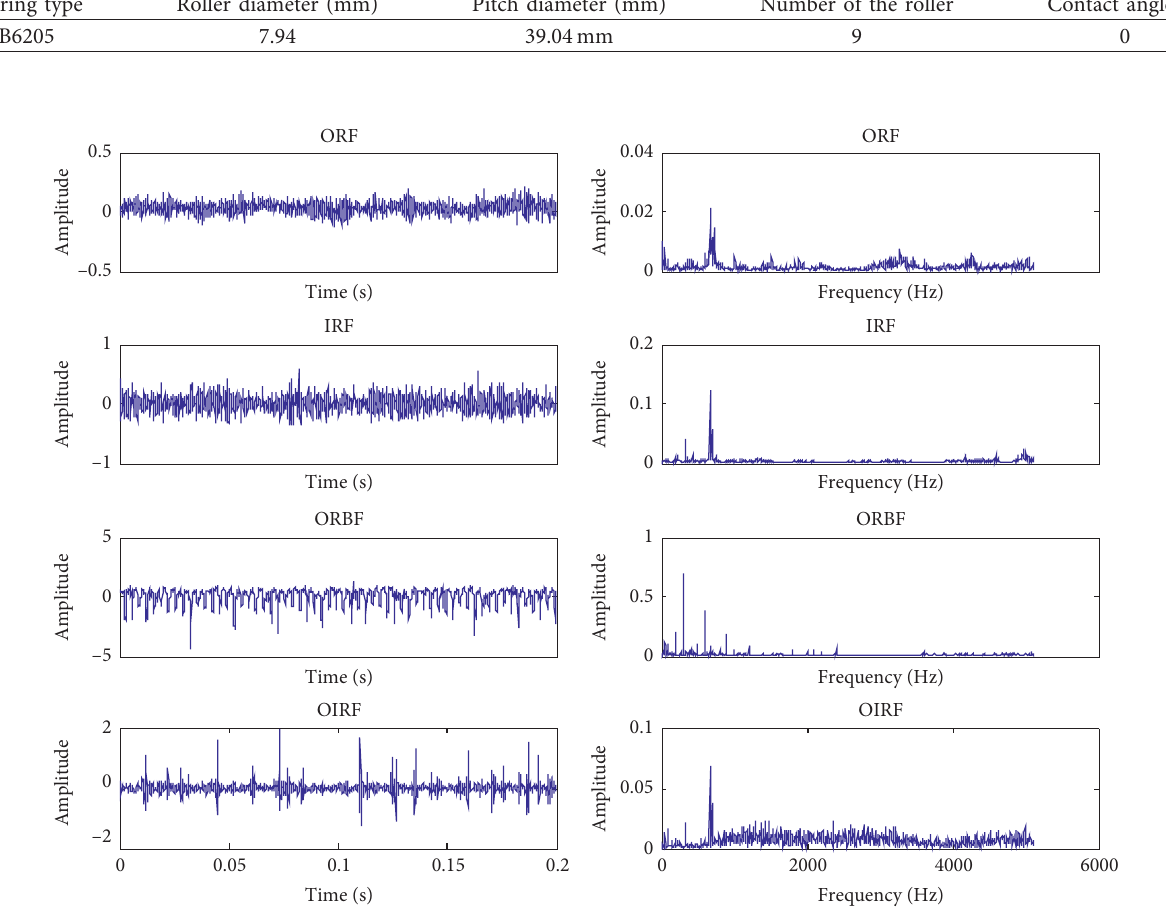
Figure 26: Temporal waveform and FFT spectrum of different bearing fault